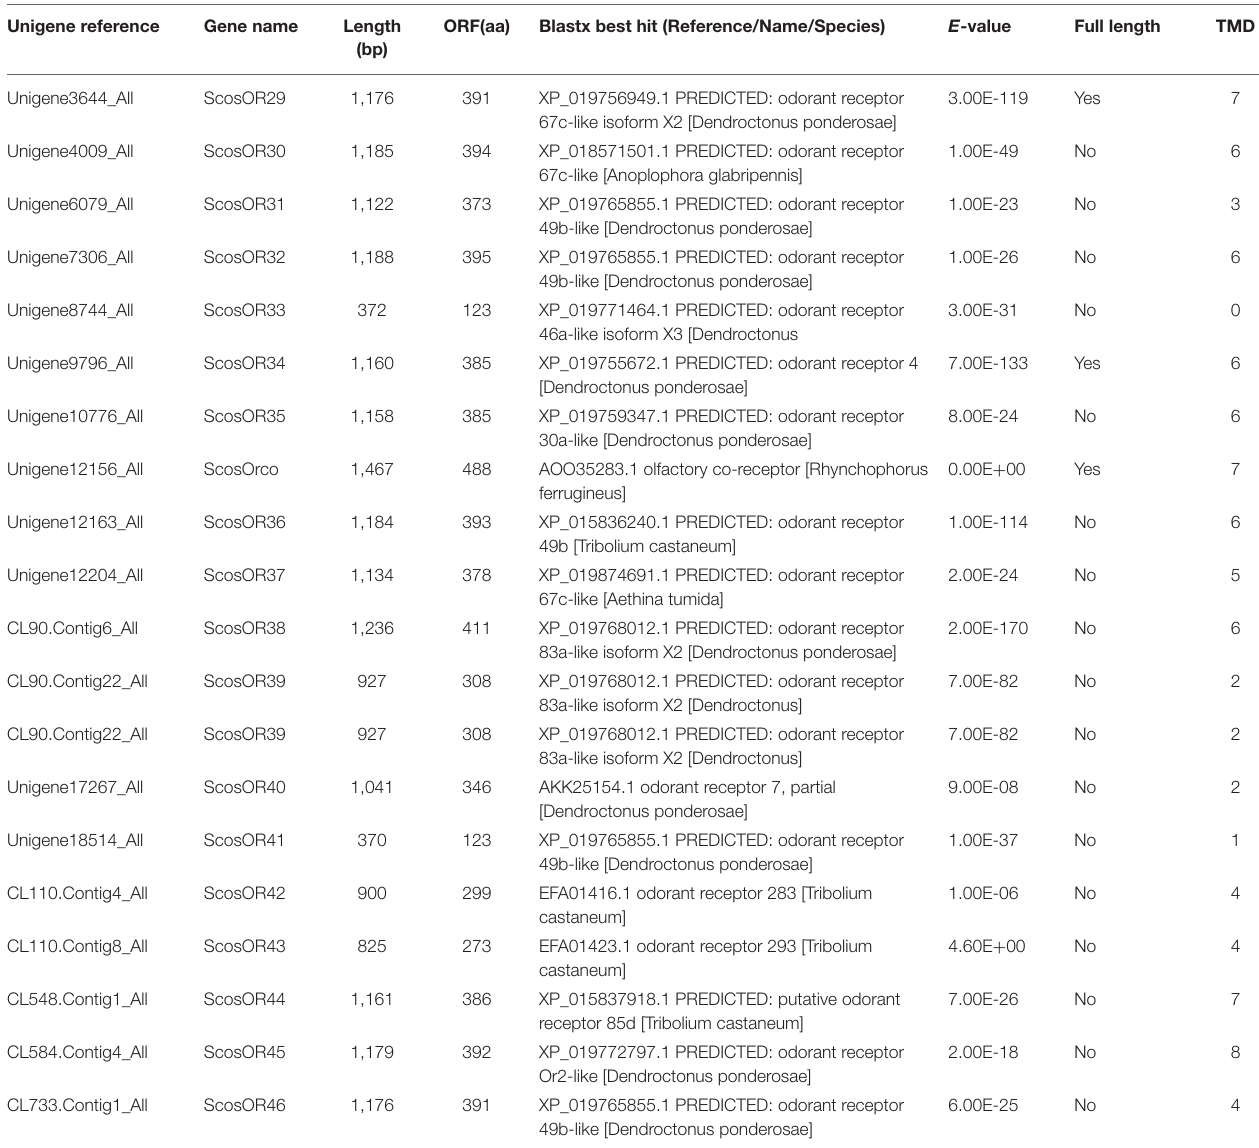
1,000 replicates. The trees were visualized, and color-coded in FigTree 1.4.3. For ORs, the tree was rooted in the Orco